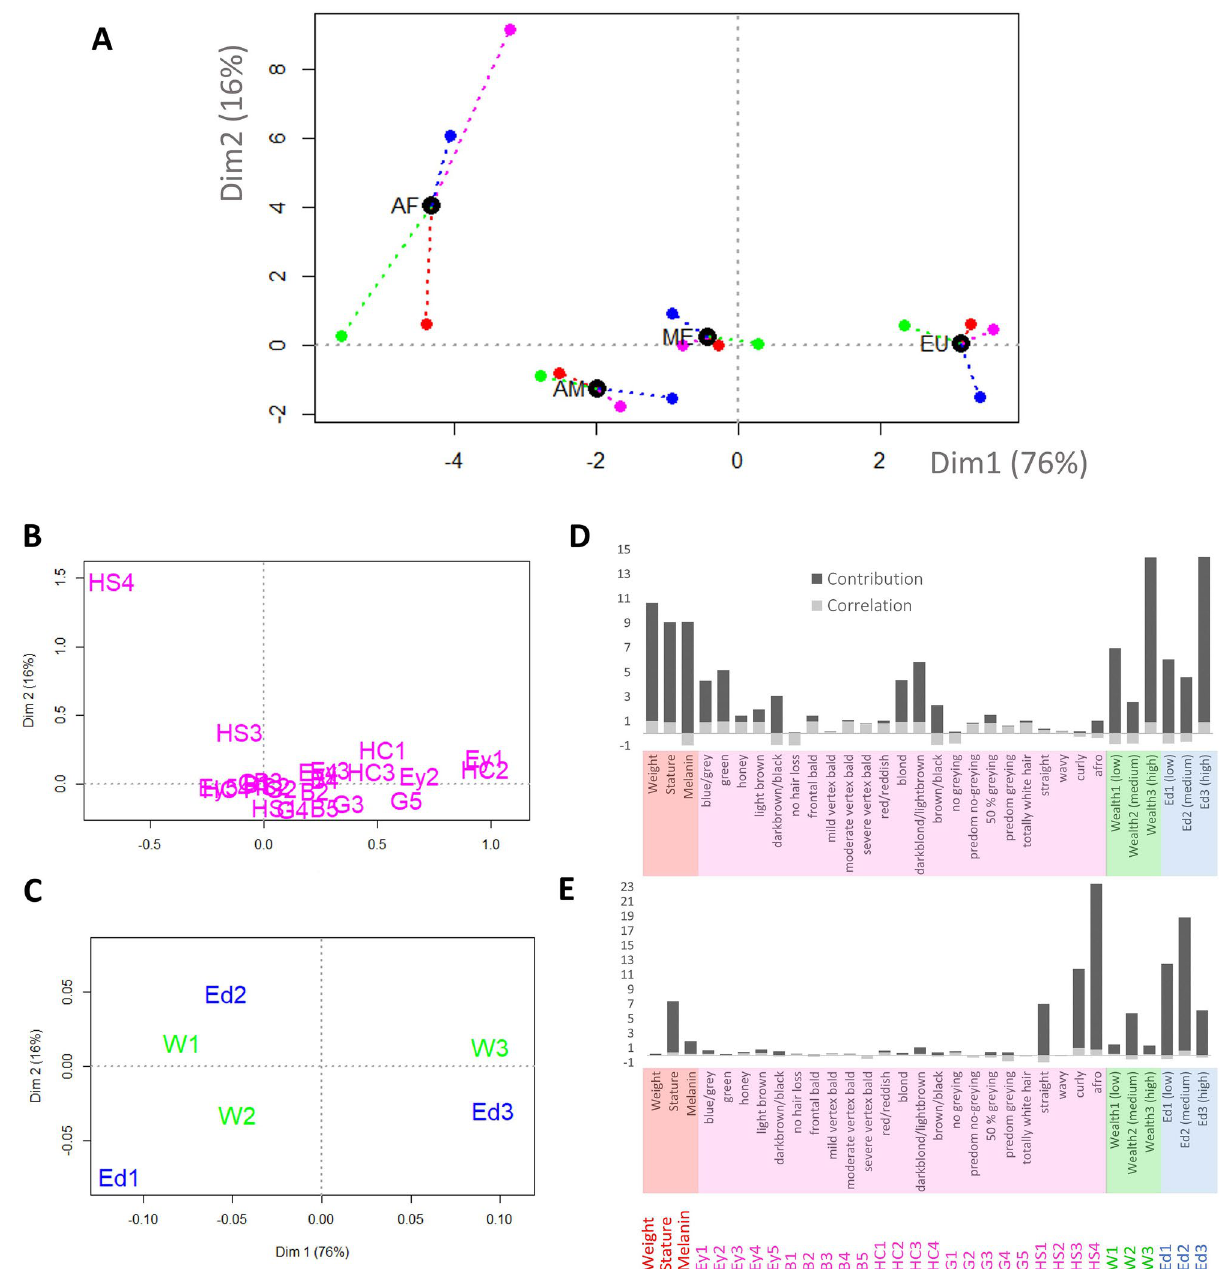
Figure 3. MFA results for the pooled sample (all countries). ( A ) The first two dimensions of the MFA showing simultaneously the global average (black dots) for each ESP category (AF: Africans, AM: Amerindians, EU: Europeans, and ME: mestizos), and the variation among them according to each block of variables (quantitative variables or quanti_PHEN; qualitative variables or quali_PHEN; wealth variables; education variables). Global average (black dots) are joined to their corresponding partial points, depicting the influence of each set of variables (e.g. colored dots or partial points denote the position of each individual seen only by a given group of variables). ( B , C ) Plot of MFA’s coordinates of the qualitative phenotypic ( B ) and sociocultural ( C ) categories as listed in Supp. Table S3. ( D , E ) Correlation and Contribution values of all individual variables to the MFA’s first ( D ) and second ( E )